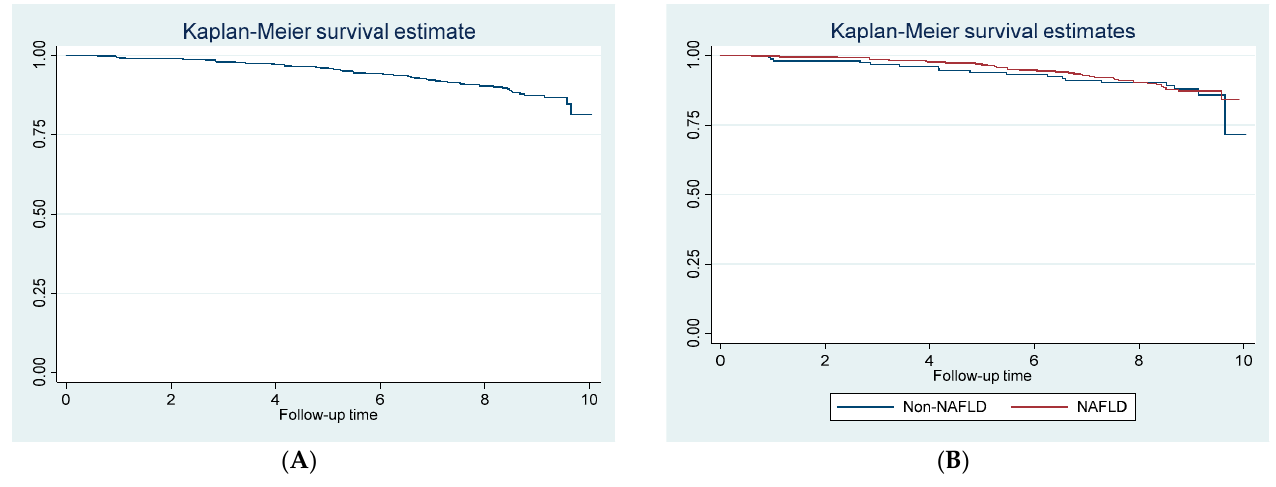
Figure 2. Kaplan–Meier curves of mortality outcome for ( A ) the whole cohort and ( B ) subgroups of patients with and without nonalcoholic fatty liver disease. Table 3. Cox proportional hazards regression model with time-varying covariates for mortality outcome. Covariates Adjusted Hazard Ratios